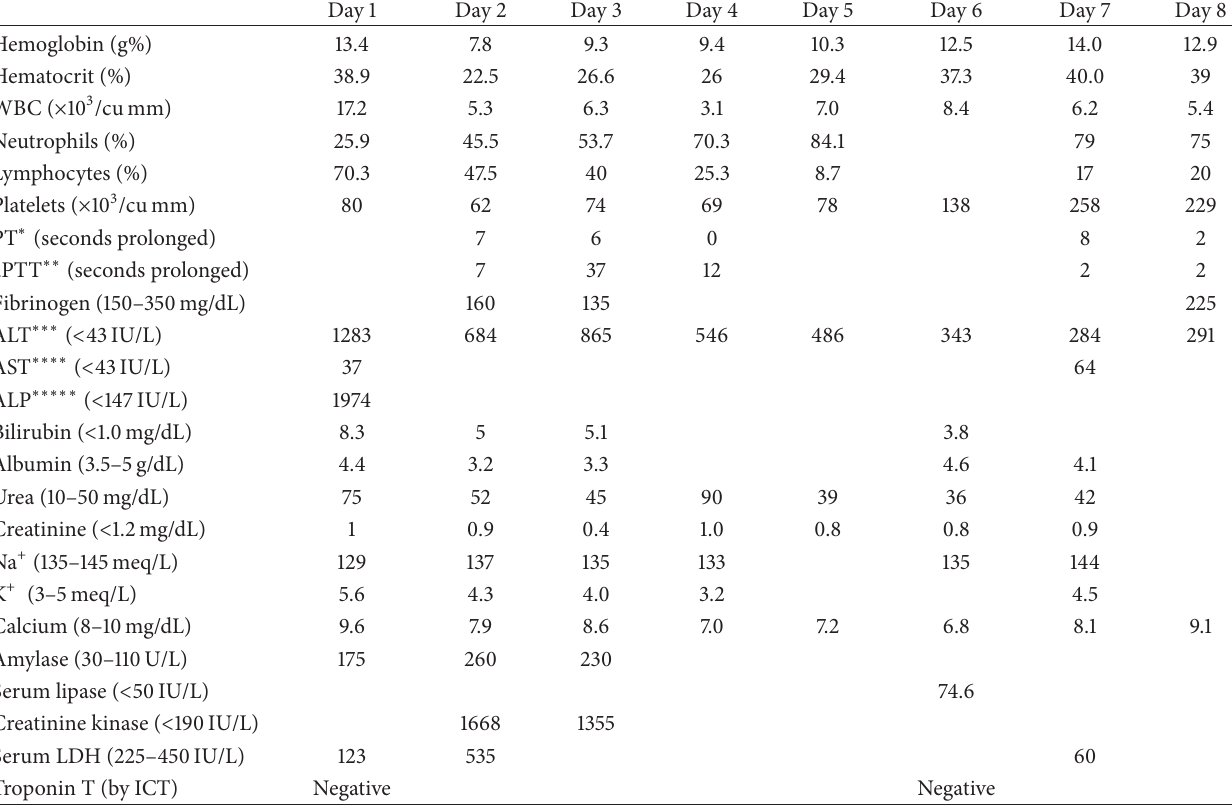
Table 1: Hematological and biochemical